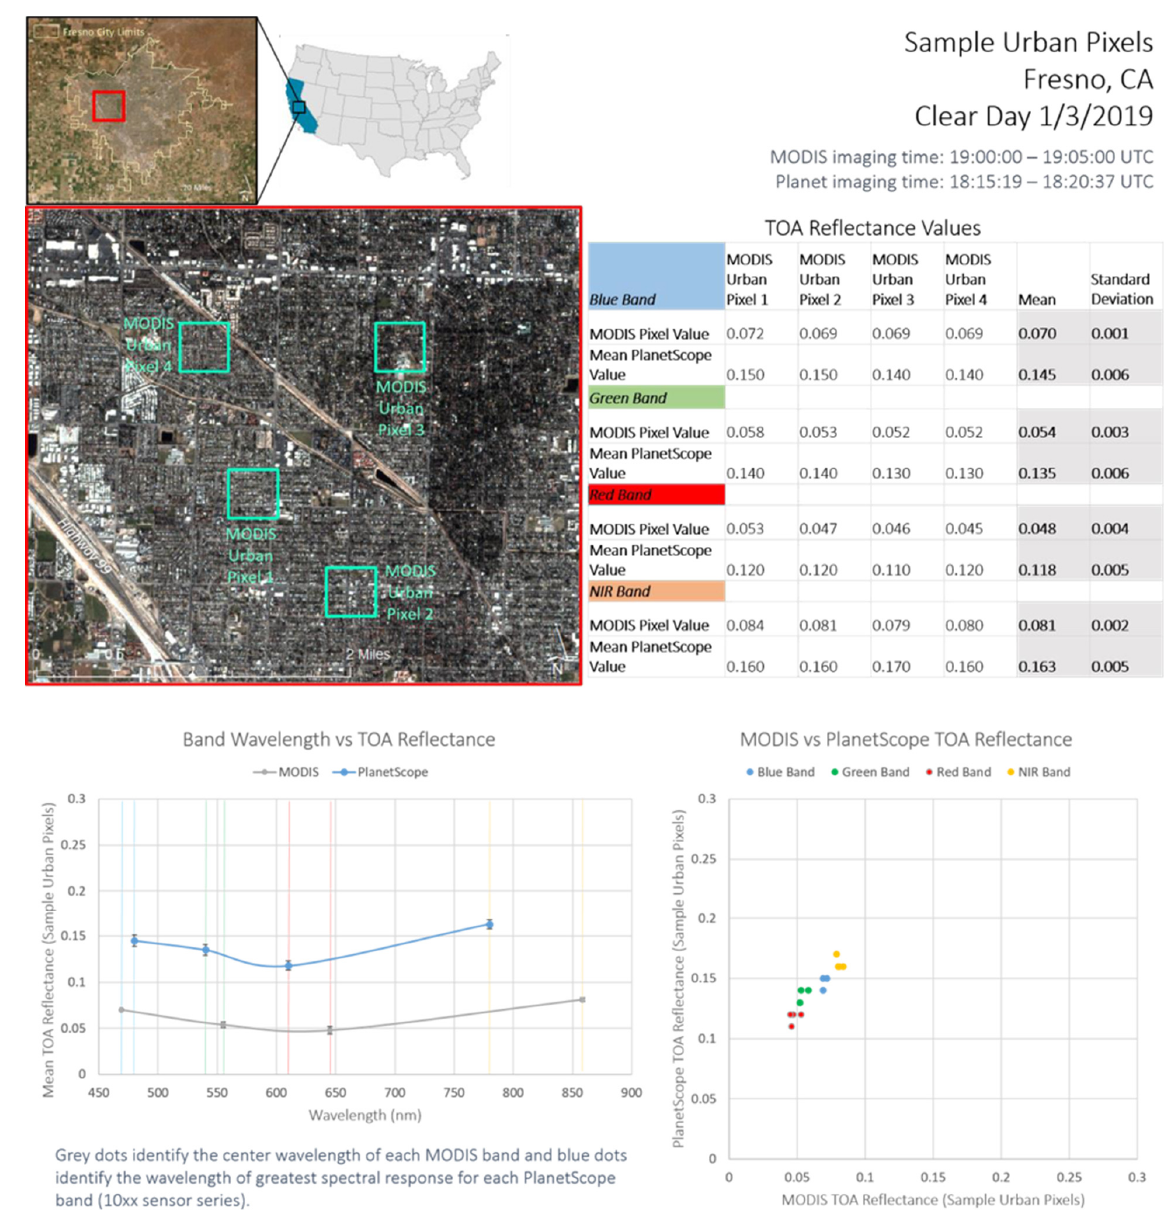
Figure A2. Results from Section 3.2 for pixels sampled over an urban area in the Fresno study area on 1/3/2019.